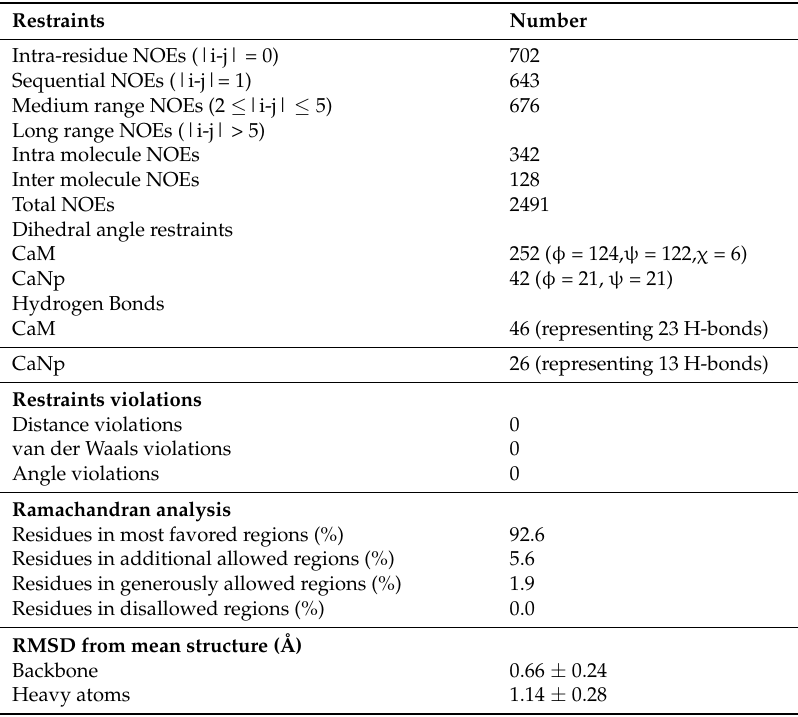
Table 1. Structural statistics of 20 lowest-energy structures of CaM/CaNp